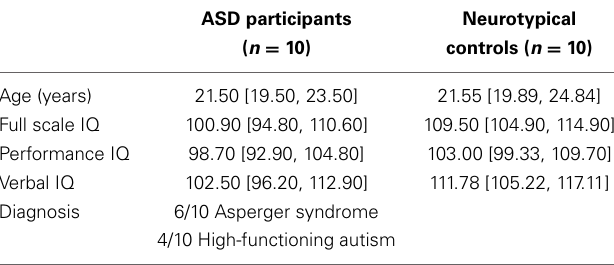
Table 1 | Demographic and clinical characteristics of the